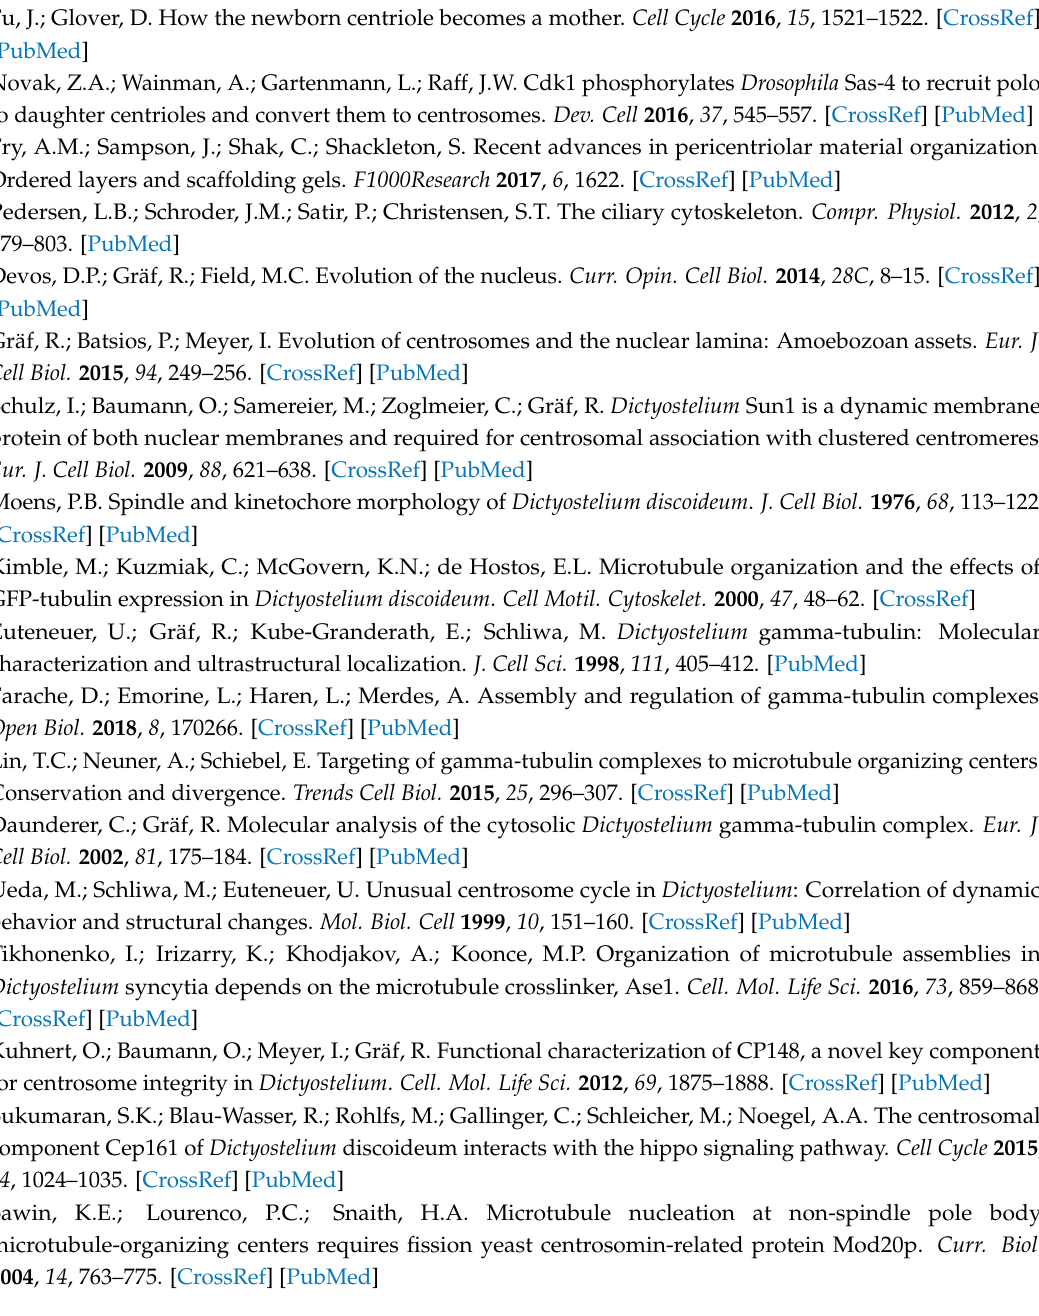
Figure S1: Resolving power of widefield deconvolution microscopy, Figure S2: GFP-CDK5RAP2 is present at mitotic spindle poles, Video S1: GFP-CDK5RAP2 briefly disappears from the centrosome during prophase, Video S2: GFP-CDK5RAP2ki shows hardly any recovery after